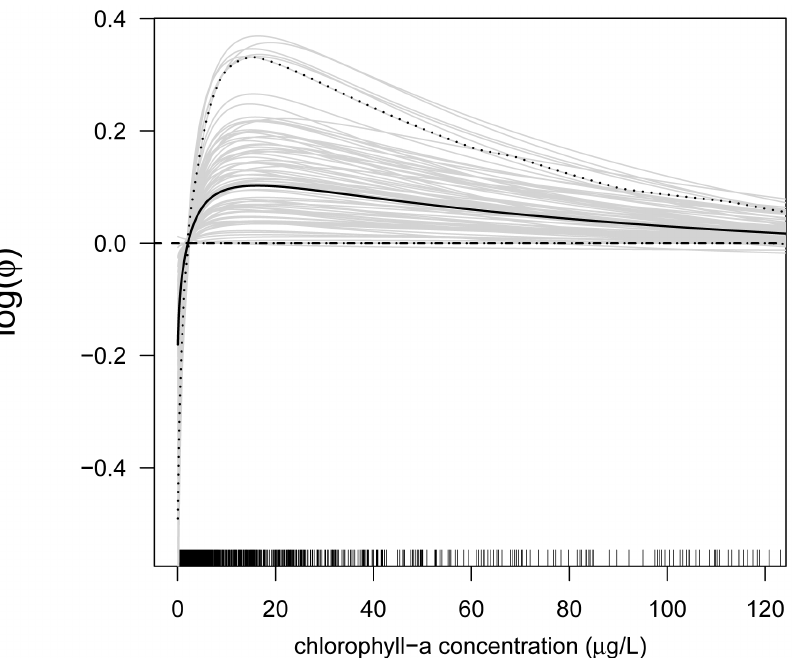
Figure 13. Effect of chlorophyll- a concentration on the precision parameter. Analysis of the NLA Data. The figure contains the estimated effect of the chlorophyll- a concentration on the logarithm of the precision parameter w (computed from 100 bootstrap samples). Black lines correspond to the mean and the 0.05 and 0.95 quantiles of the function estimates. For reasons of interpretability, the range of the x-axis was restricted to the lower 95% of the sample values.